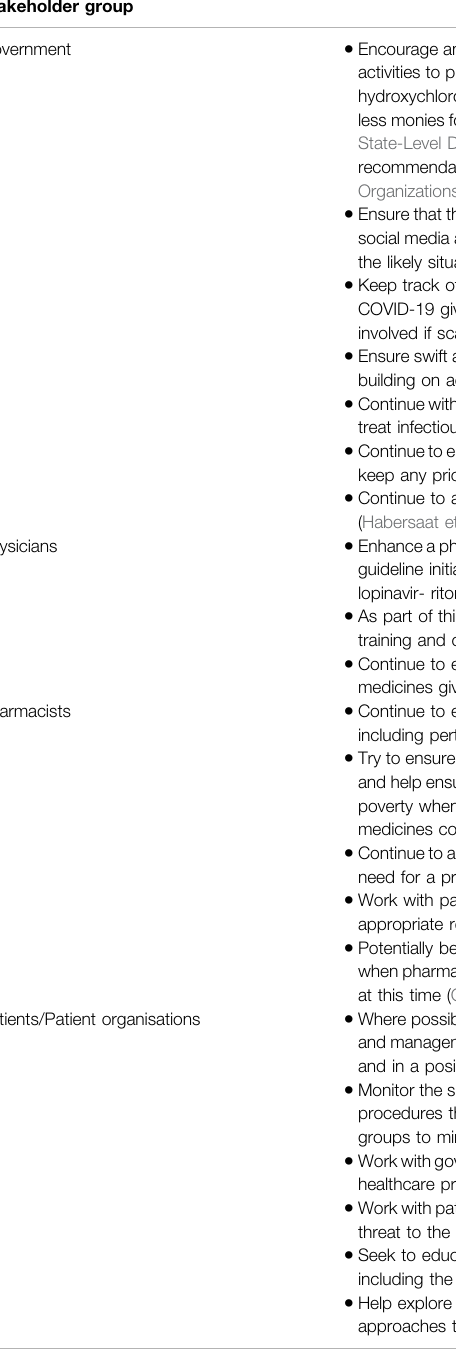
TABLE 7 | Key activities among stakeholder groups to improve prevention and management of patients with COVID-19. Stakeholder group